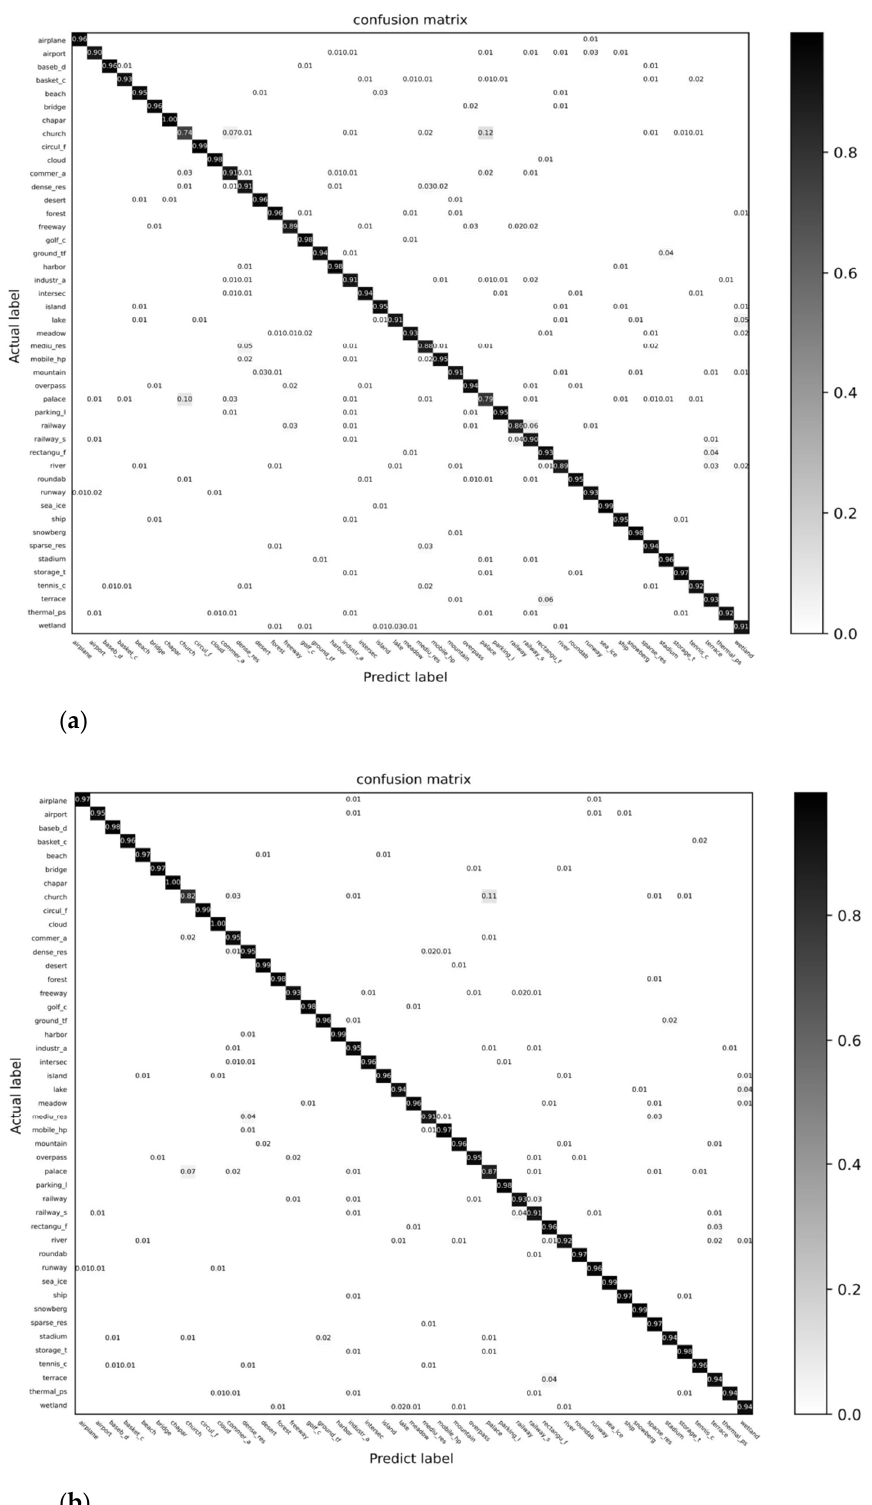
Figure 8. Confusion matrices of the NWPU-RESISC45 dataset. ( a ) Linear evaluation under the 10% training ratio. ( b ) Linear evaluation under the 20% training ratio.